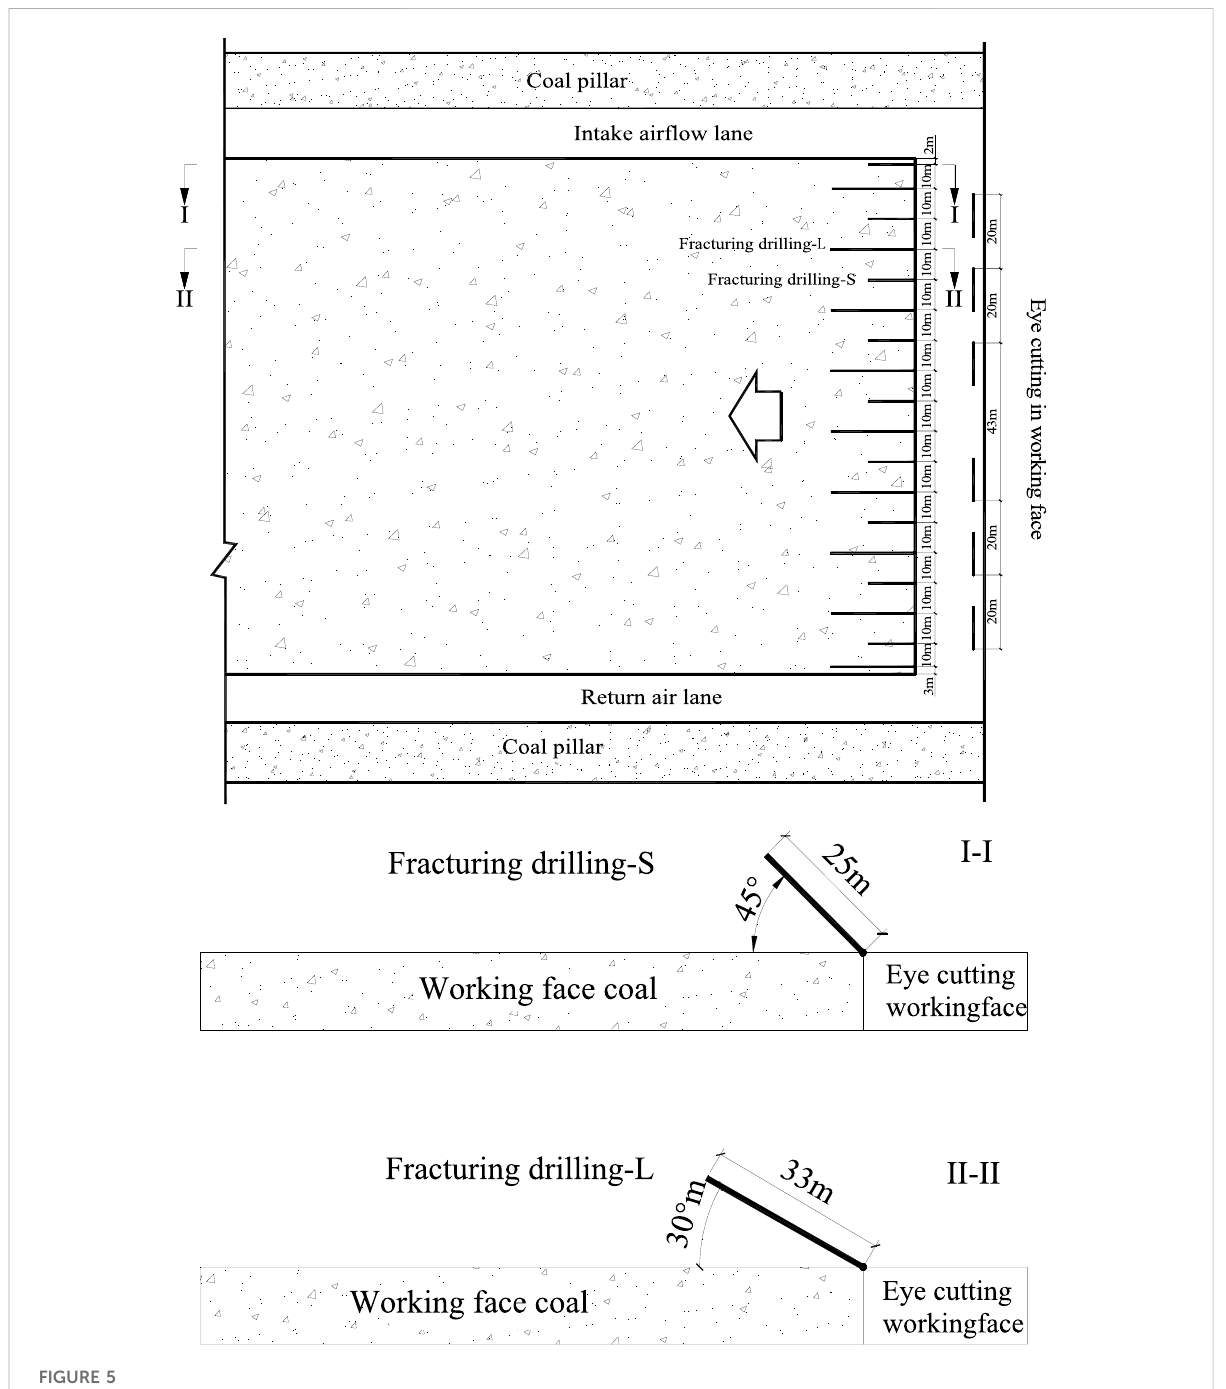
FIGURE 5 Borehole layout for hydraulic fracturing of the working